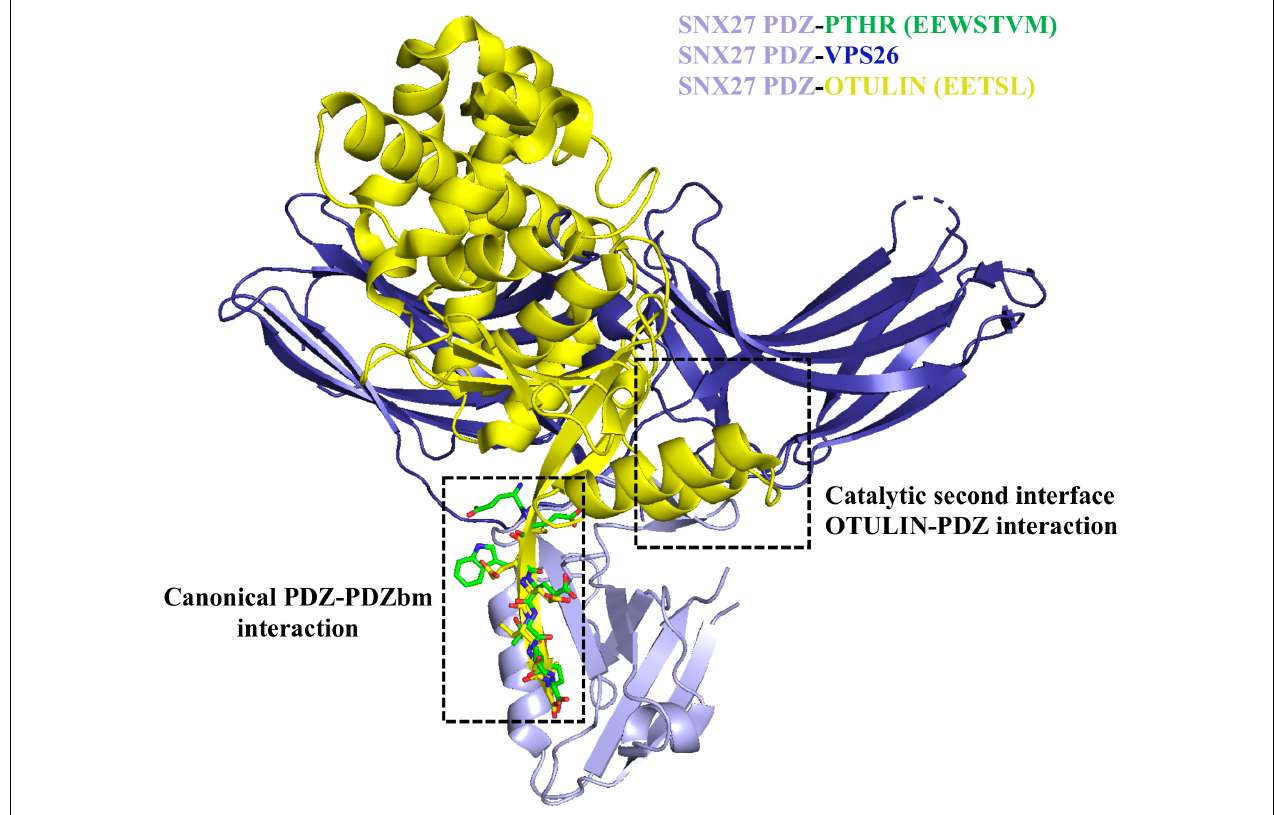
FIGURE 5 | Sorting nexin 27 (SNX27) binding to retromer and OTULIN. The SNX27 PDZ domain (light purple ribbons; PDB: 4Z8J) with a PDZbm (green cylinders) is shown with both VPS26 (dark blue ribbons; PDB ID: 4P2A) and OTULIN (yellow ribbons; PDB ID: 6SAK). Structural data suggest the interaction of SNX27 PDZ with retromer/cargo or OTULIN is mutually exclusive. OTULIN engages both the PDZbm site using a class I PDZbm and the β -hairpin required for interacting with